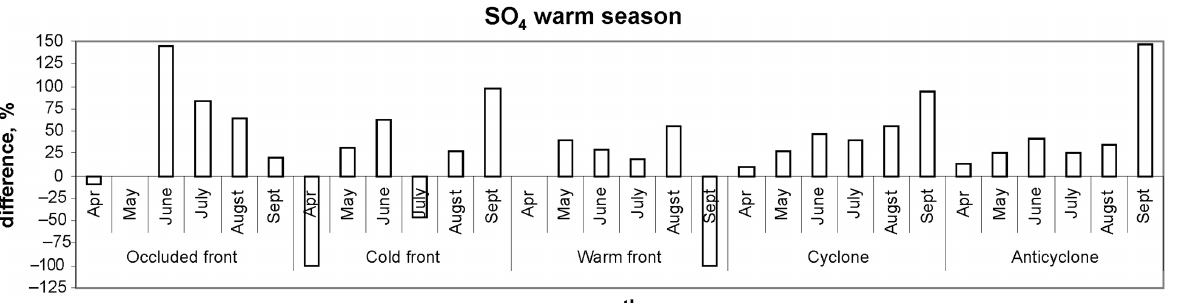
Fig 9. Difference between SO 4 three-year monthly average and average concentration during warm season at Preila background